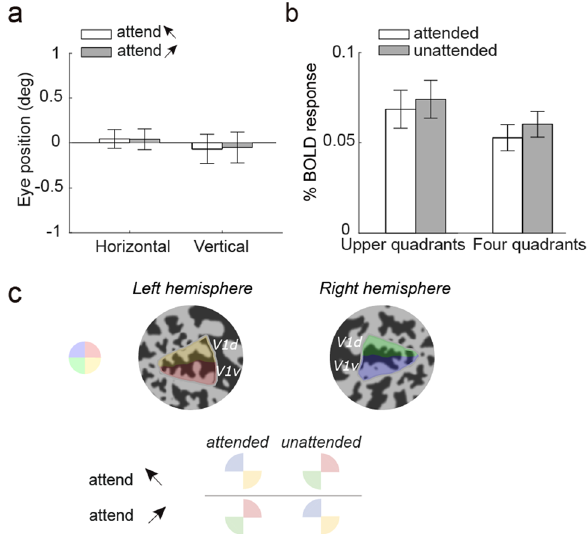
Figure 4. ( a ) Average group-level eye position for the preparation period during behavioral training. ( b ) The averaged BOLD response from the two upper quadrants and all four quadrants for attended vs. unattended locations in V1. Error bars denote within-subject errors. ( c ) A schematic of the quadrant representations in V1. Two flat patches (for the left and right occipital cortex) of a single subject are shown, with quadrants color-coded (upper-left inset shows locations in the visual field). The lower panel depicts the hypothetical scenario in which subjects attended to one of the upper quadrants, or attended to two opposite quadrants when instructed to attend to a specific motion